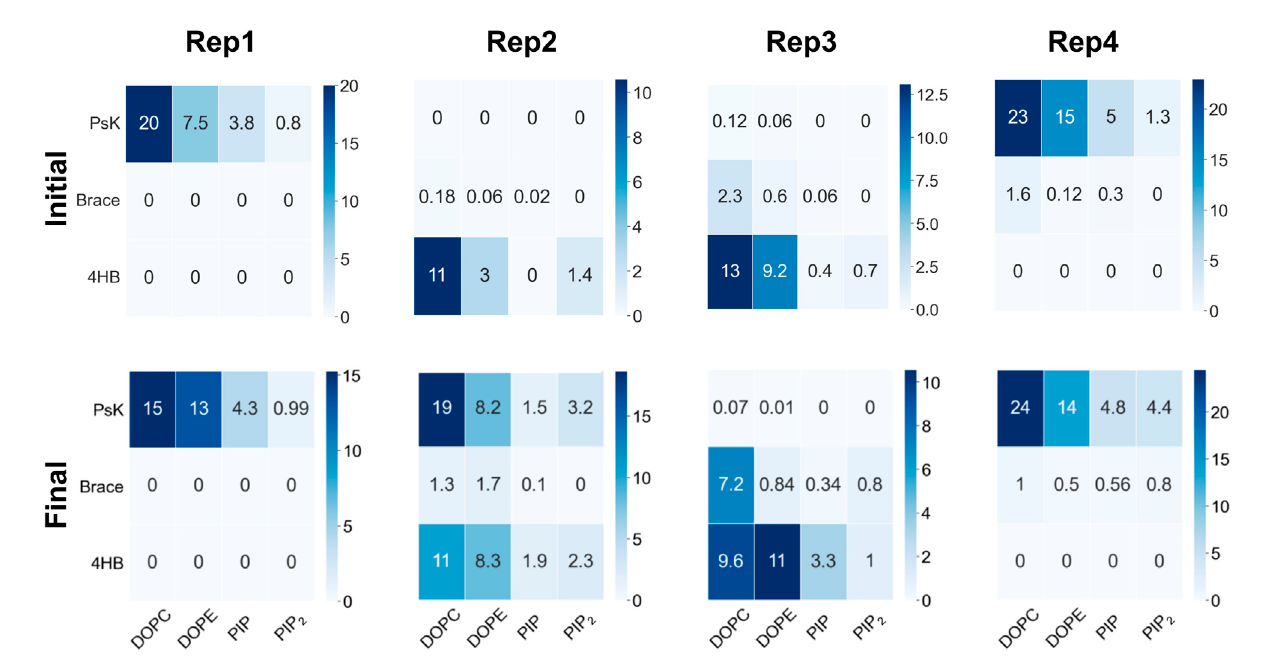
FIGURE 2 Number of contacts per protein domain versus lipid type during the initial 100ns upon protein binding (top row), and the last 200ns of trajectory, when lipid re-sorting has stabilized in response to protein binding (bottom row). The columns correspond to Rep1-Rep4 as labeled in the top of the fi gure. For all replicas,aprotein-lipidcontactiscountedwhenatomsinaproteindomainarewithin12 (cid:1) Aofthephosphateatomsintherespectivelipidspeciesinthebinding lea fl et. Blue shade darkens as number of contacts